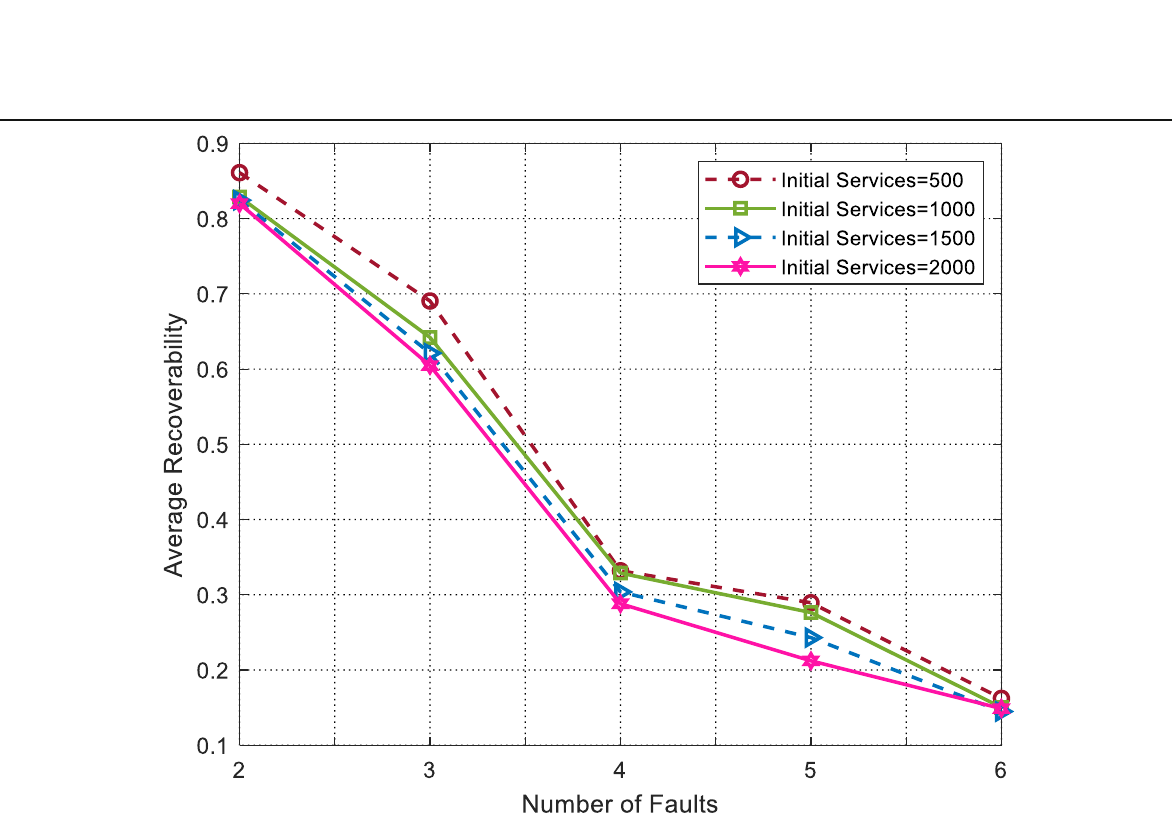
Fig. 10 Average recoverable ratio no. of link failures. This figure depicts the variation of average service recovery ratio versus the number of link failures when the initial number of services is 500, 1000, 1500, and